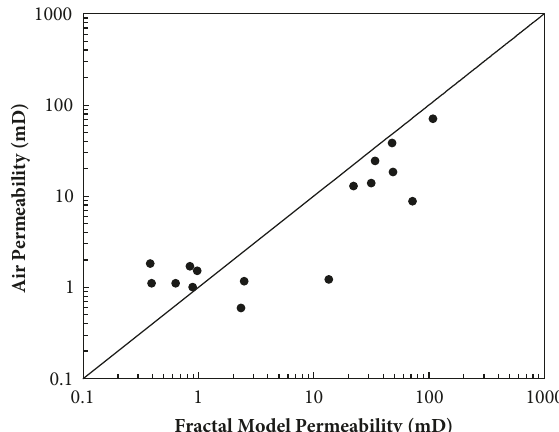
Figure 15: Comparison between the measured air permeability and the calculated permeability using fractal permeability model.